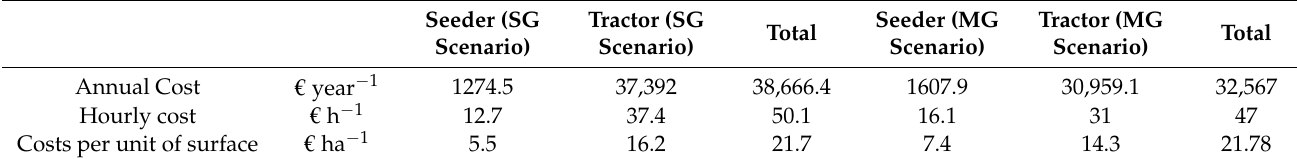
Table 5. Table of the cost considering semi-automatic guidance and manual guidance